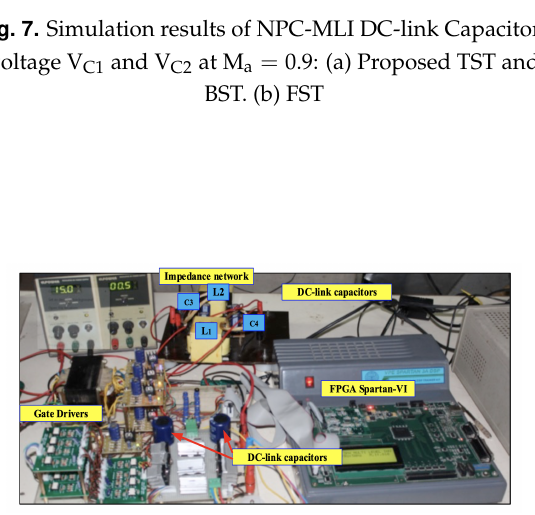
Fig. 8. Experimentation setup of three-phase 3L Z-NPC-MLI fed induction motor